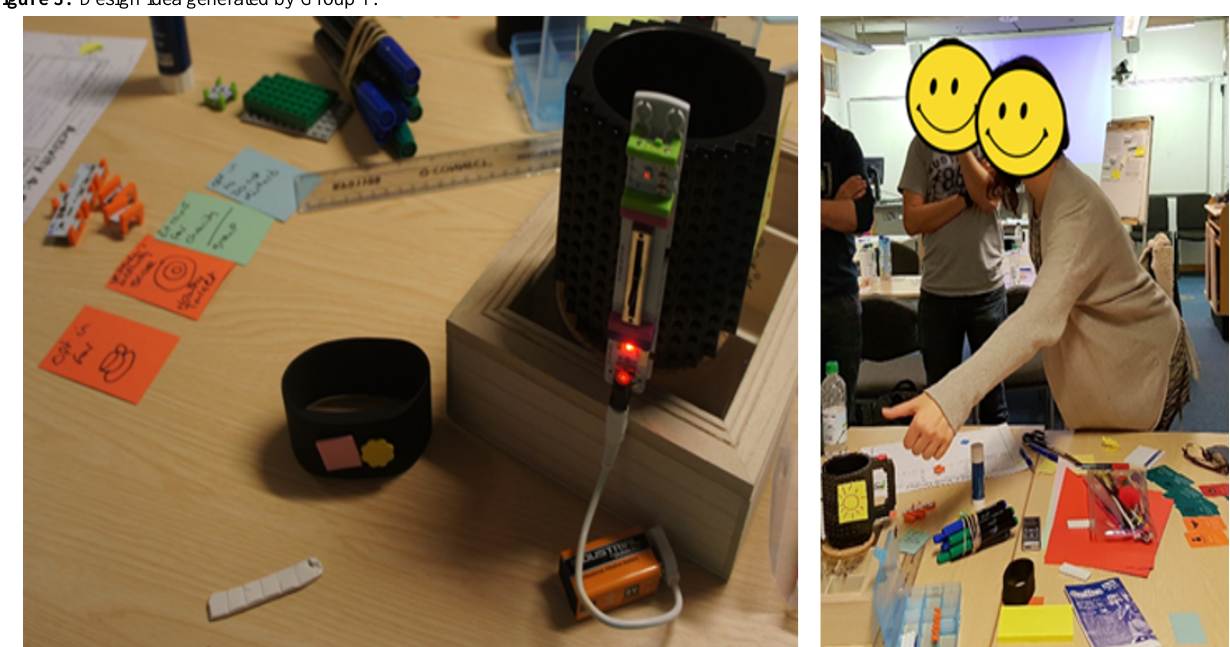
Figure 3. Design idea generated by Group